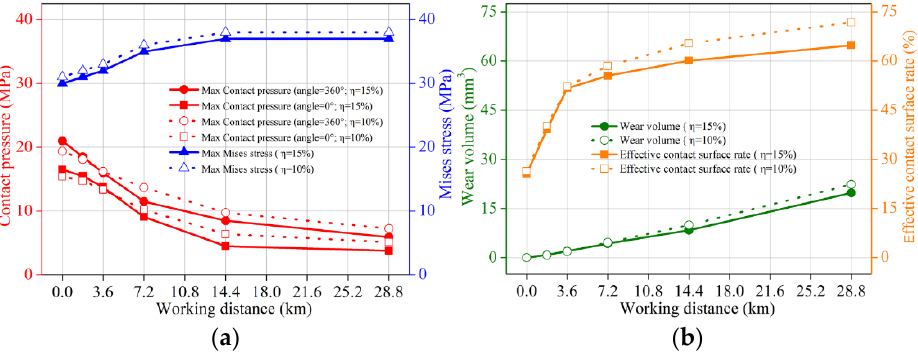
Figure 18. ( a ) Maximum contact pressure and maximum mises stress; ( b ) Wear volume and effective contact surface rate of C-ring under different pre-compression rate.